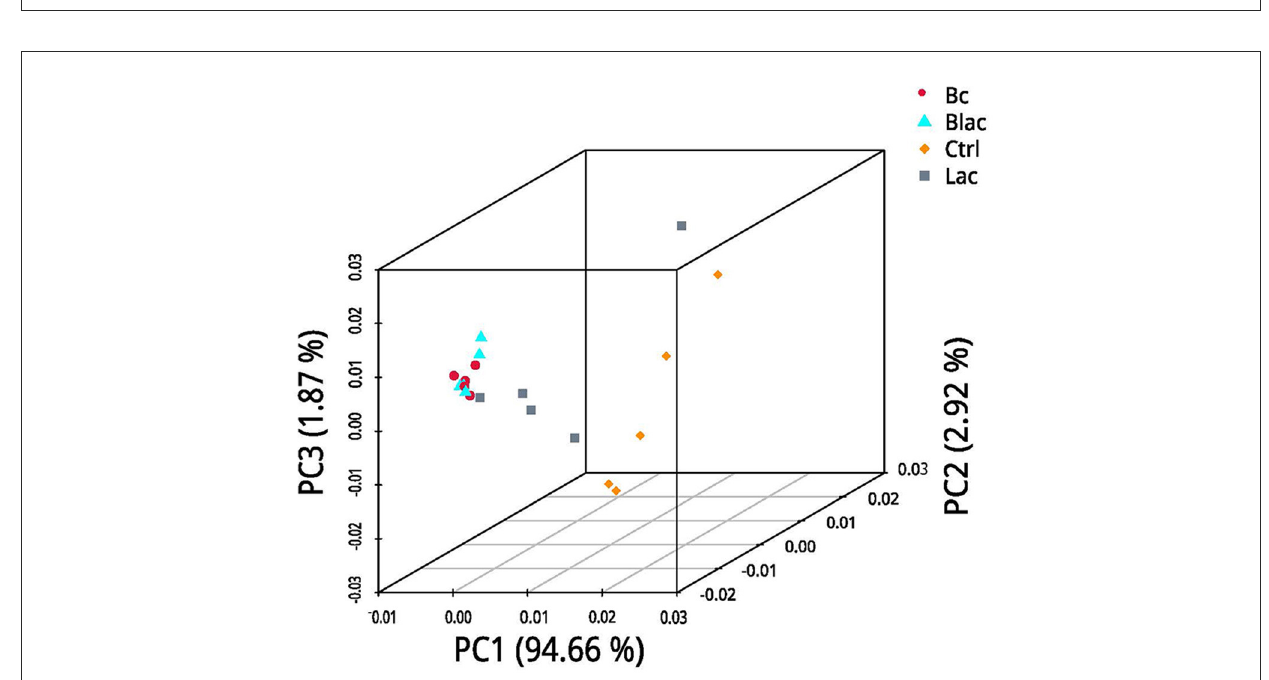
FIGURE8 Principal component analysis (PCA); Bc, added with strain B. cereus AH7-7; Blac, added with strain B. cereus AH7-7, Lactobacillus plantarum, and Lactobacillus buchneri ; Lac, added with Lactobacillus plantarum and Lactobacillus buchneri ; Ctrl, no